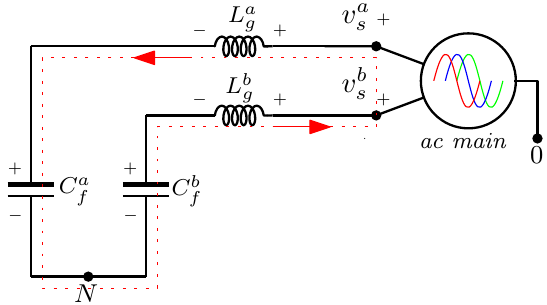
Figure 4. Grid–side mesh: simplified